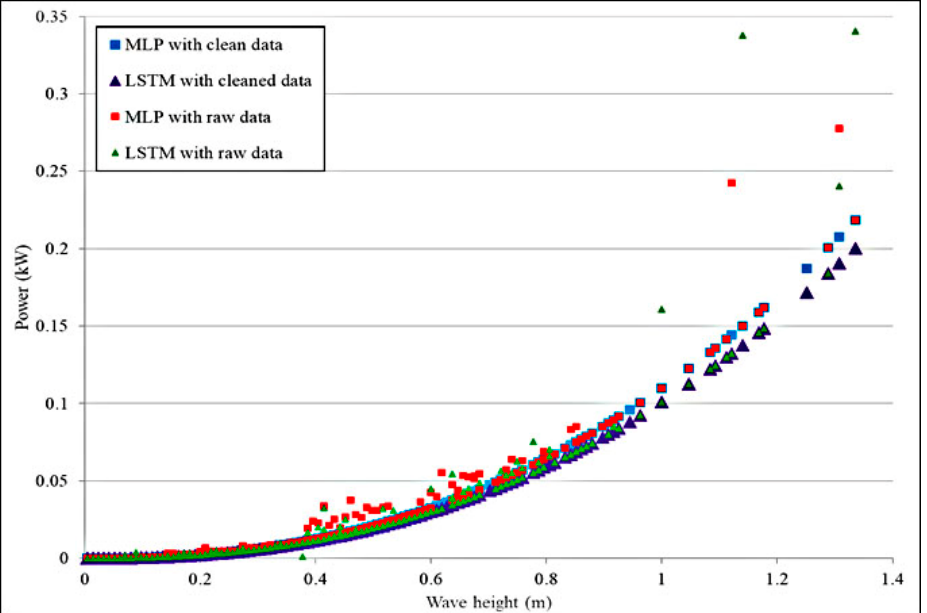
Figure 8. Two classes of forecasting procedure power with two algorithms.